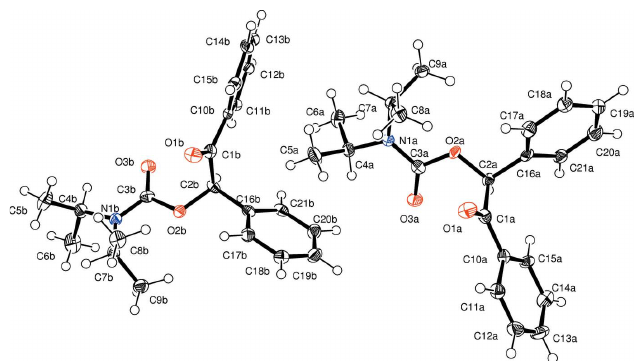
Figure 1 Molecular structures of both enantiomers of the title compound with displacement ellipsoids drawn at the 50% probability level ( R left; S